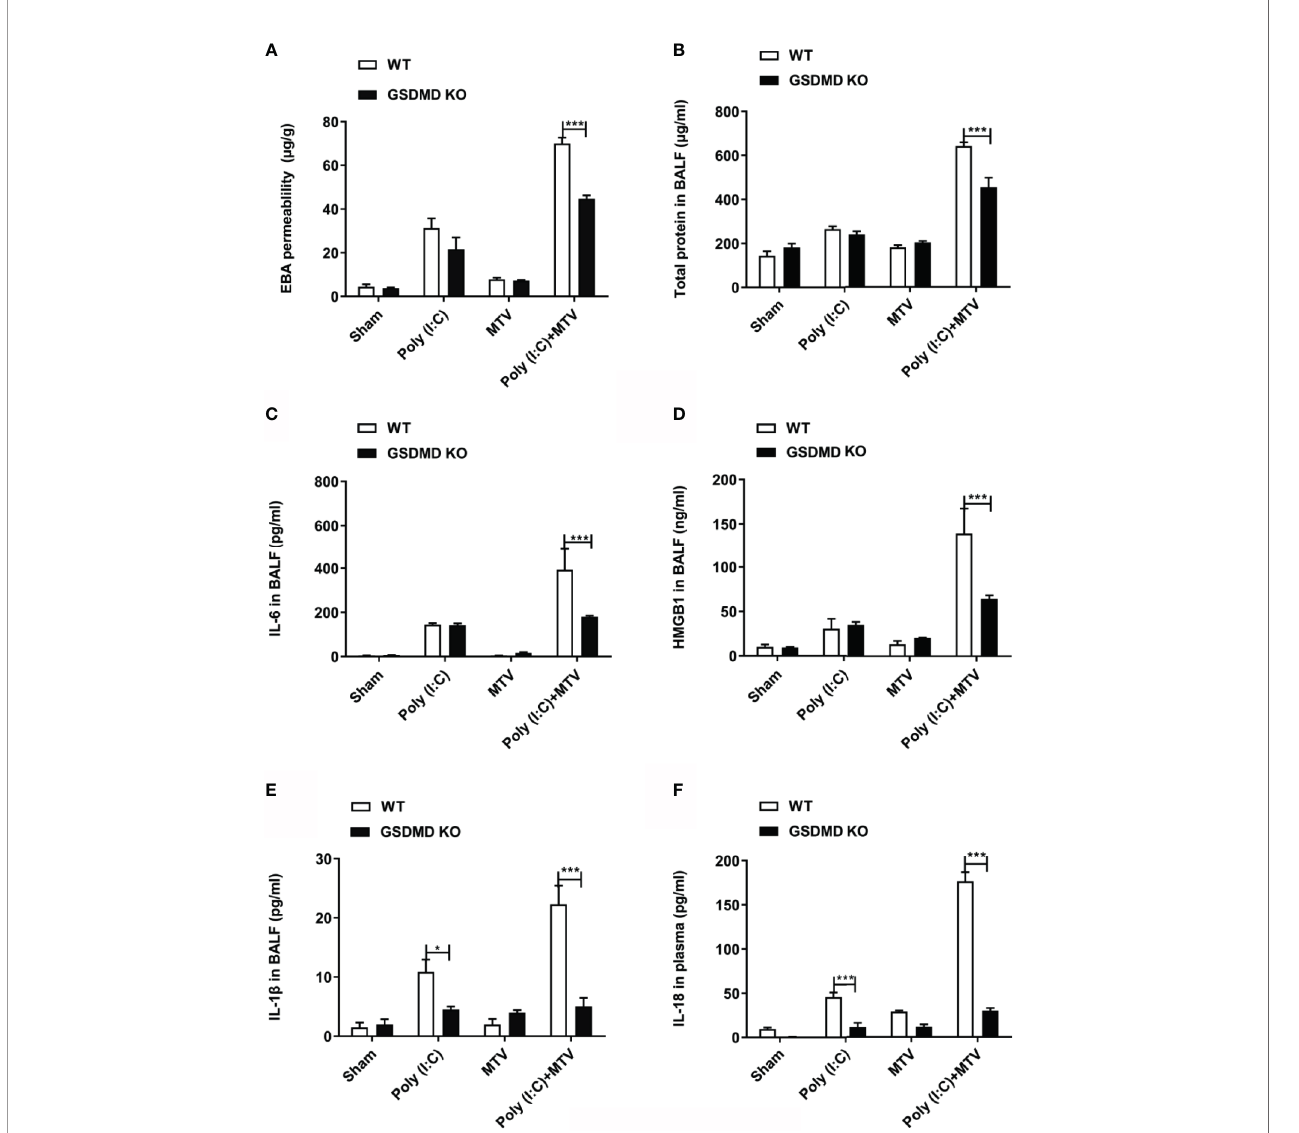
FIGURE 7 | GSDMD was required for Poly(I:C)-MTV induced lung injury. Poly(I:C)-MTV increased EBA permeability, (A) , total protein (B) , IL-6 (C) , HMGB1 (D) , and IL-1 b (E) in BALF as well as IL-18 levels (F) in plasma in WT but were inhibited in GSDMD KO mice. n=5 of each group for WT mice and GSDMD -/- mice. Results are shown as means ± SEM and compared by one-way ANOVA and Student-Newman-Keuls test. *** p <